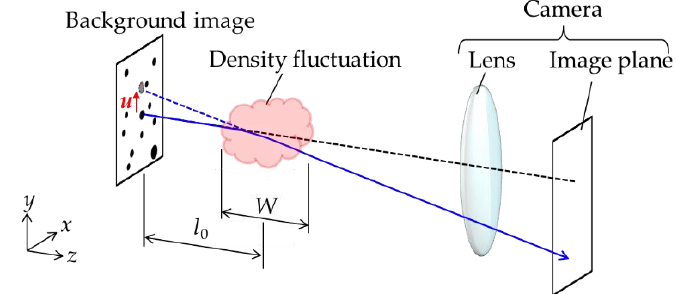
Figure 5. Principle of the BOS technique.